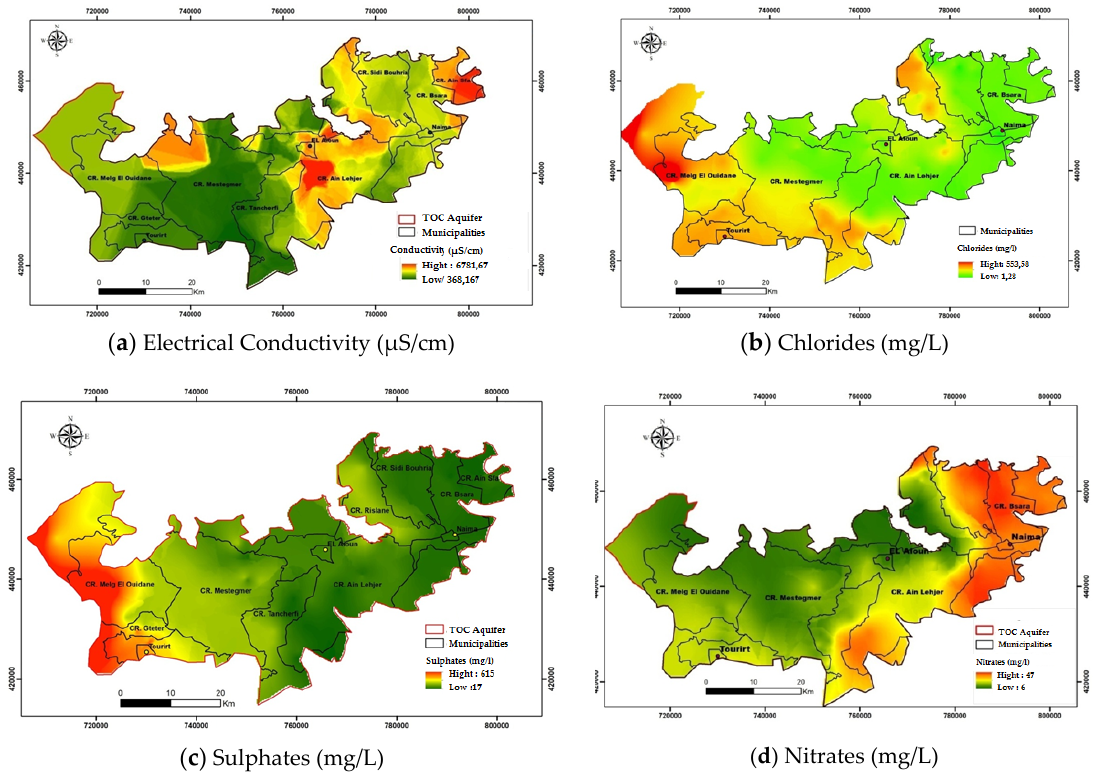
Figure 10. Spatial distribution of concentrations of ( a ) electrical conductivity; ( b ) Chlorides; ( c ) Figure10. Spatialdistributionofconcentrationsof( a )electricalconductivity; ( b )Chlorides; ( c )Sulphates; Sulphates; and ( d ) nitrates in T.O.C. aquifer (March 2017). and ( d ) nitrates in T.O.C. aquifer (March